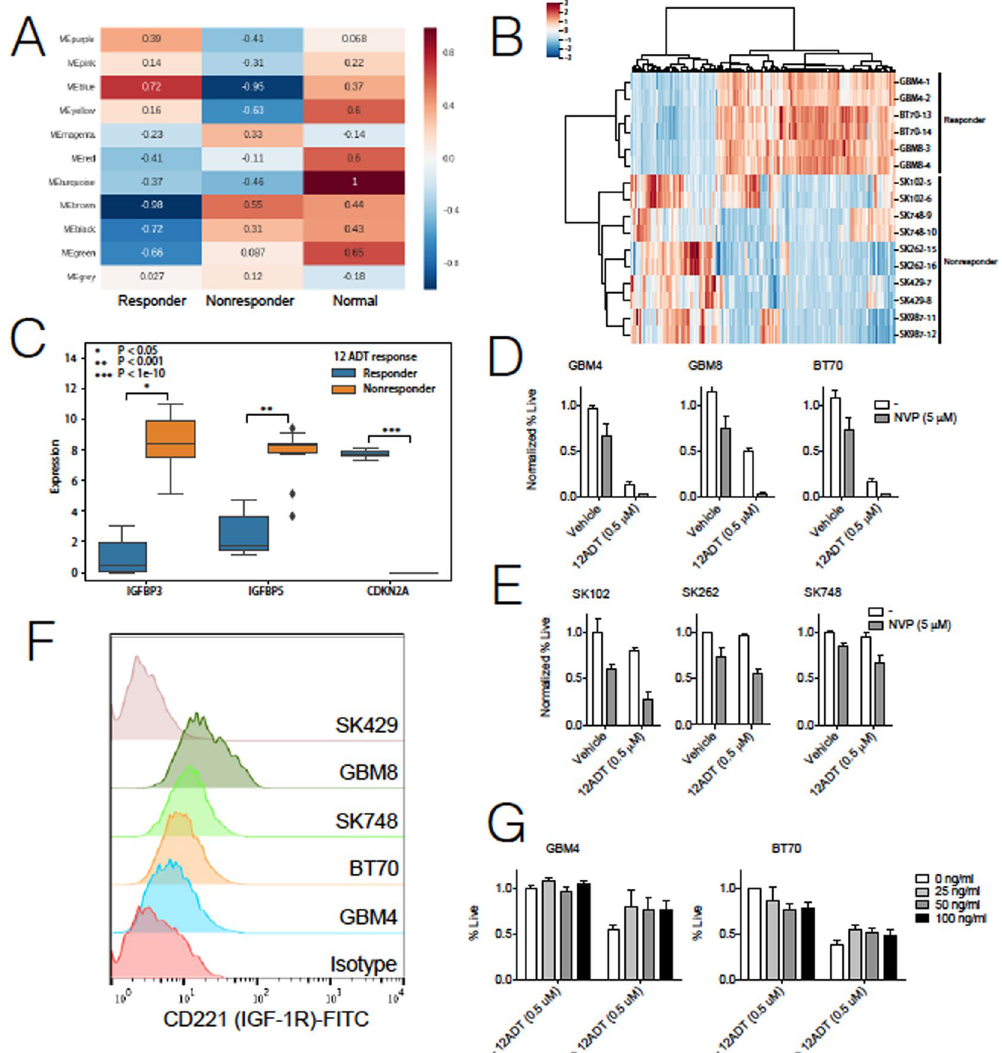
Figure 3. IGF signaling contributes to 12ADT toxicity. ( A ) Heatmap displaying Pearson correlation coefficients between eigengene profiles and sample traits for modules detected by WGCNA. Samples were divided into 2 groups according to responder or control status before evaluating correlation. MEBlue and MEBrown modules display the strongest opposing correlation between responder and nonresponder neurosphere lines. ( B ) Heatmap of gene expression across samples for genes belonging to the MEBlue module shows differential expression of genes relative to response. ( C ) Comparison of expression levels between responder and nonresponder neurosphere lines of selected genes that show strong differential expression in MEBlue (IGFBP3, IGFBP5) and MEBrown (CDKN2A). ( D ) Normalized cell survival of three responder (GBM4, GBM8, BT70) and ( E ) three nonresponder neurosphere (SK102, SK262, SK748) lines treated with 12ADT (0.5 μ M) in the absence or presence of IGF-1R inhibition (NVP-AEW541). Survival determined by flow cytometry for 7AAD negativity and normalized by percent live (7AAD − ) population of unstimulated, inhibited condition (n = 2 per group) and are representative of three independent experiments. * P ≤ 0.05, ** P ≤ 0.01, Student’s t test (paired two-tailed) ( F ) Detection of surface expression of CD221 (IGF-1R) in GBM neurosphere lines as determined by flow cytometry. ( G ) Normalized cell survival of responder cell neurosphere lines treated with 12ADT (0.5 μ M), supplemented with increasing concentrations of IGF1, after 48 hour treatment. Survival determined by flow cytometry for 7AAD negativity and normalized by percent live (7AAD − ) population of unstimulated condition where no IGF-1 supplementation occurred (n = 2 per